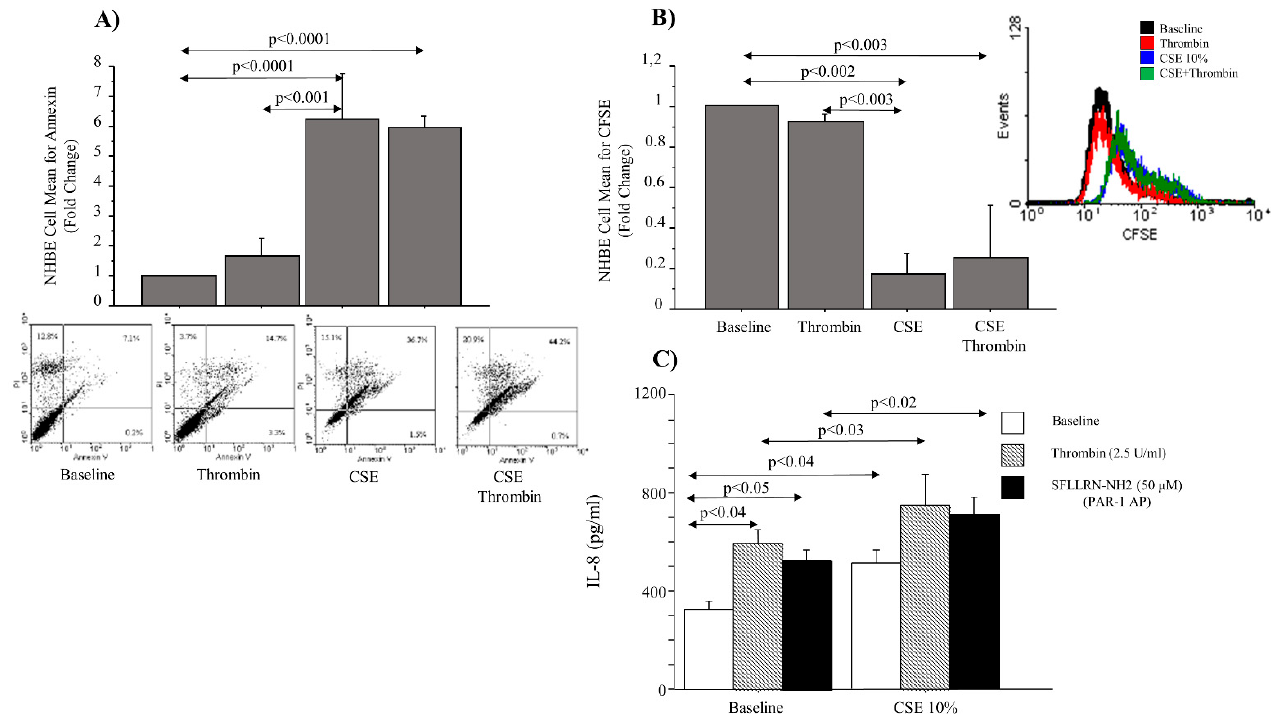
Figure 8. Cell apoptosis, cell proliferation and IL-8 release in NHBEs stimulated with thrombin and CSE. NHBEs, cultured in the presence and absence of thrombin at 2.5 U/mL, alone or in combination with CSE at 10%, were used for evaluating ( A ) apoptosis using an Annexin V Test (see Materials and Methods for details) and ( B ) proliferation using a CFSE test (see Materials and Methods for details). Bars represent the mean ± SD fluorescence intensity (MFI) of three separate experiments and were plotted as fold changes compared to the untreated cells, which were chosen as the reference sample. Representative flow cytometry of cell apoptosis and of cell proliferation are shown ( C ) as IL-8 release in NHBEs stimulated with thrombin 2.5 U/mL or SFLLRN-NH2 (50 µM) (PAR-1 AP) in the presence or absence of CSE at 10%. The values shown are the mean ± SD of three separate experiments. Statistical analysis was performed by ANOVA test followed by Fisher’s PLSD multiple comparison test.